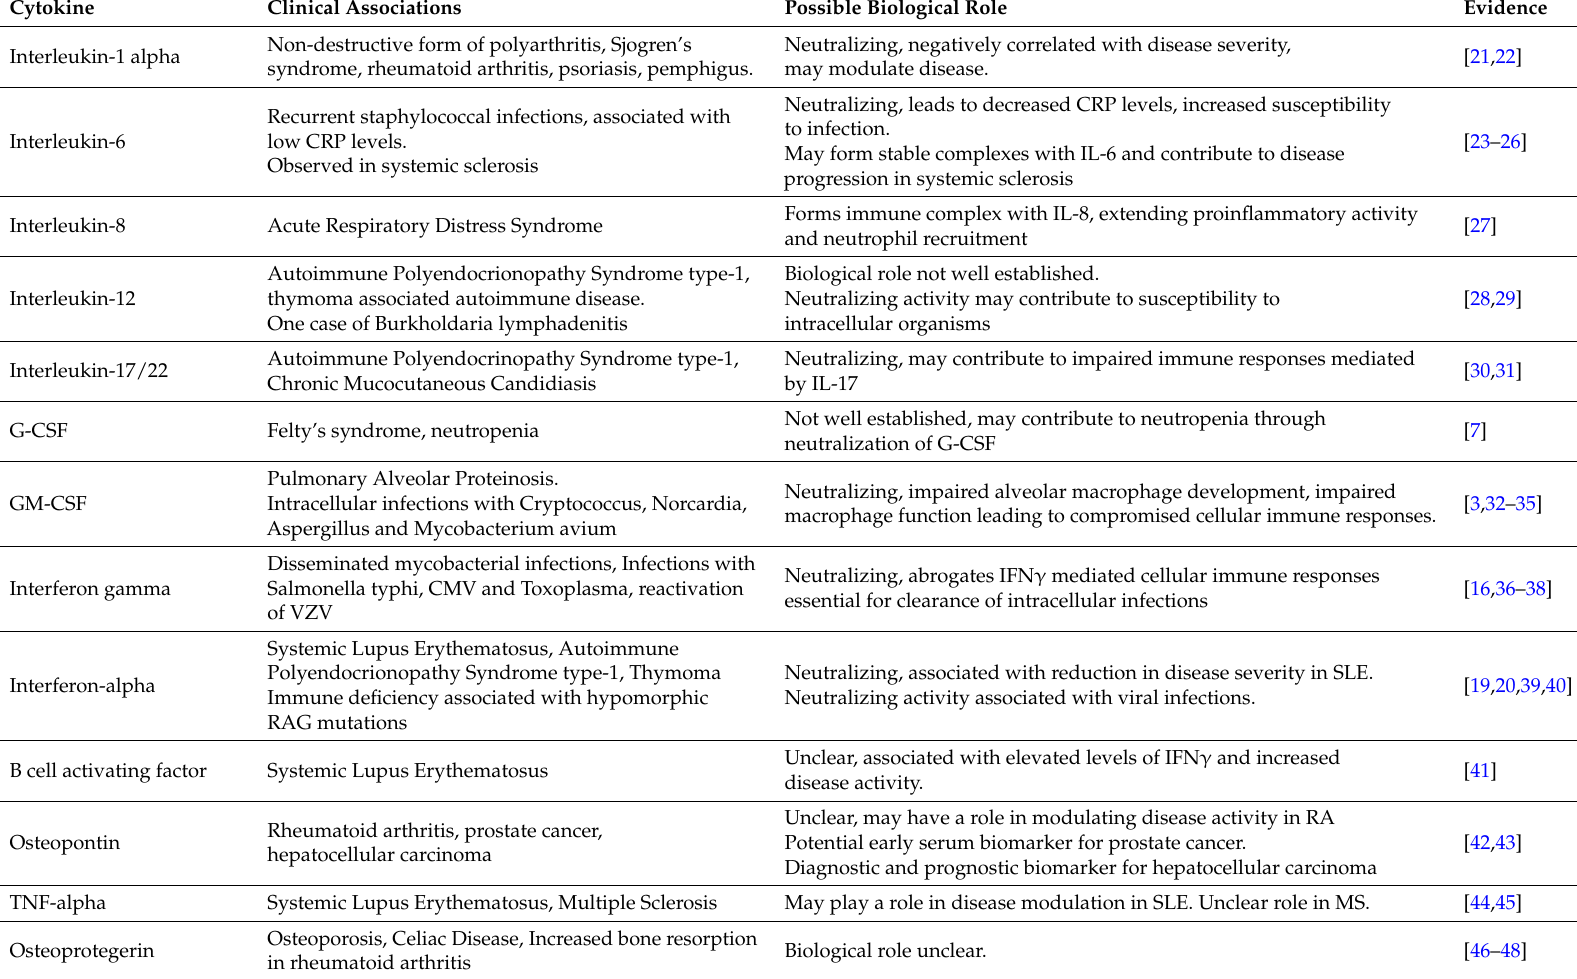
Table 1. Anti-cytokine AAbs associated with disease states identified to